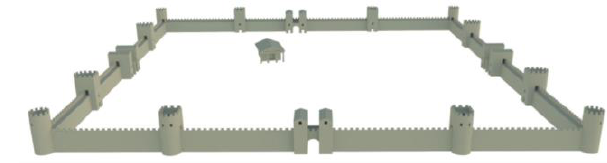
Figure 7: 3D model of the castellum without texture.